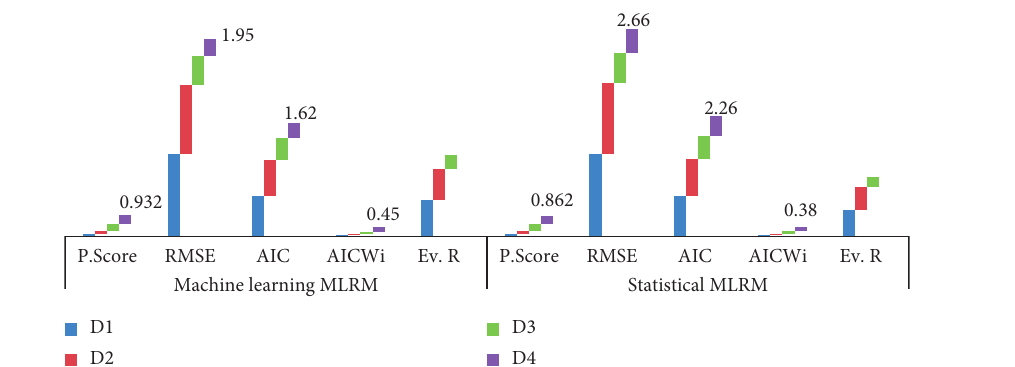
Figure 8: Integrating/comparisons of machine learning and statistical models.